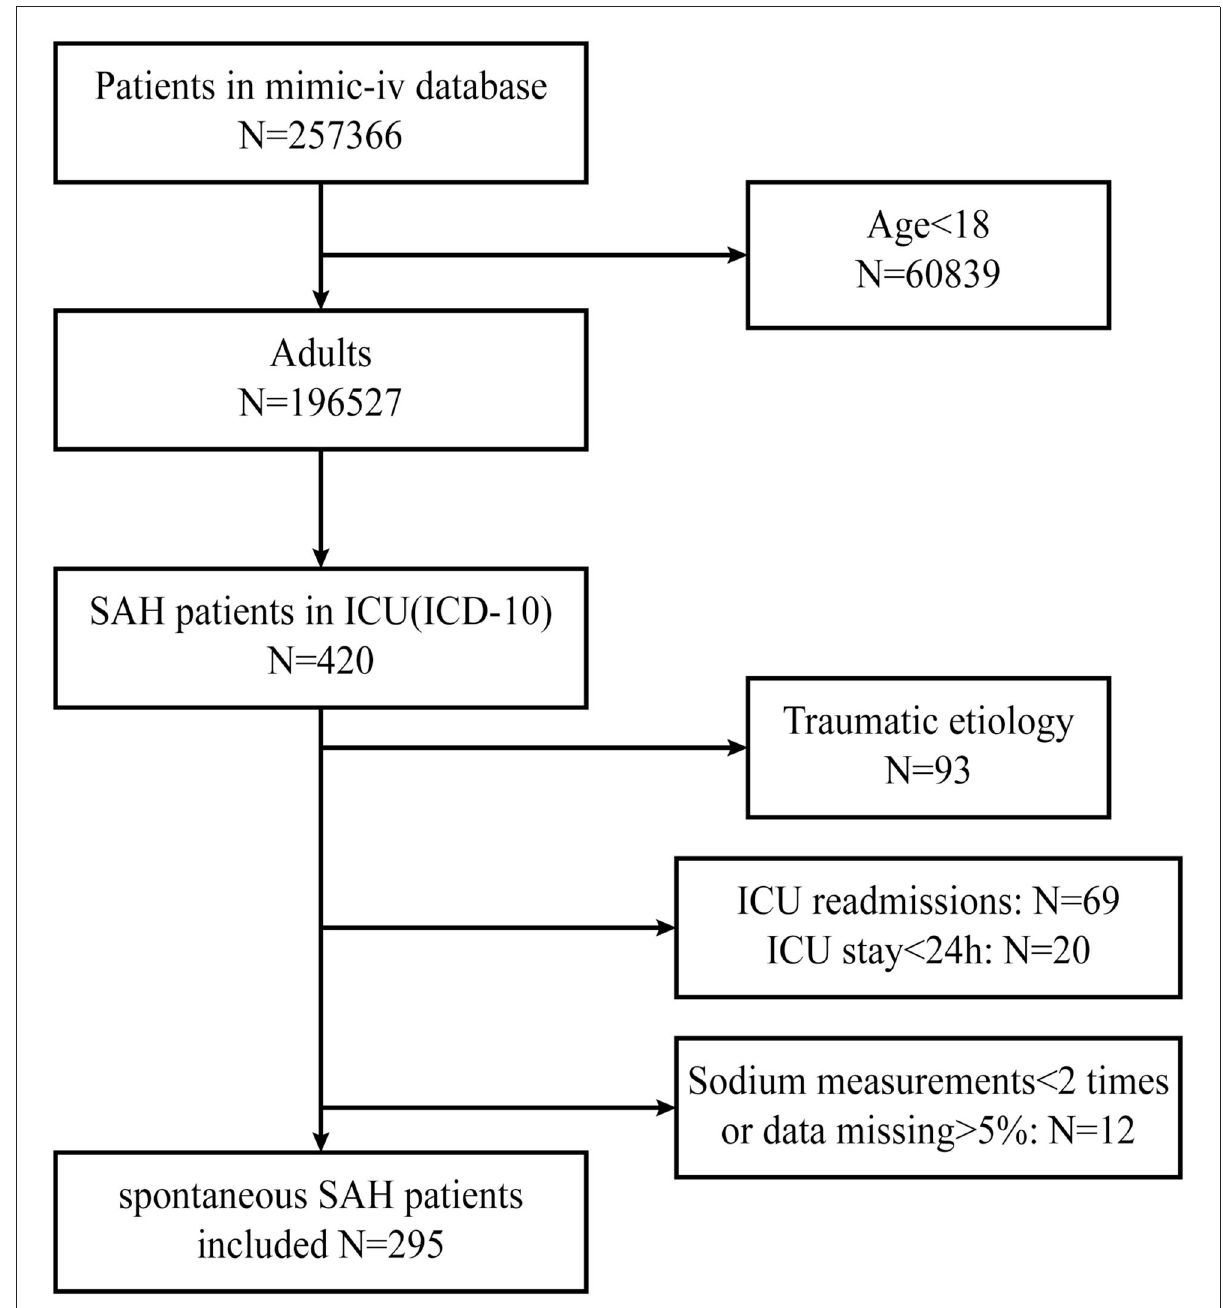
FIGURE1 Flowchart screening for eligibility. MIMIC, Medical Information Mart for Intensive Care; SAH, subarachnoid hemorrhage.